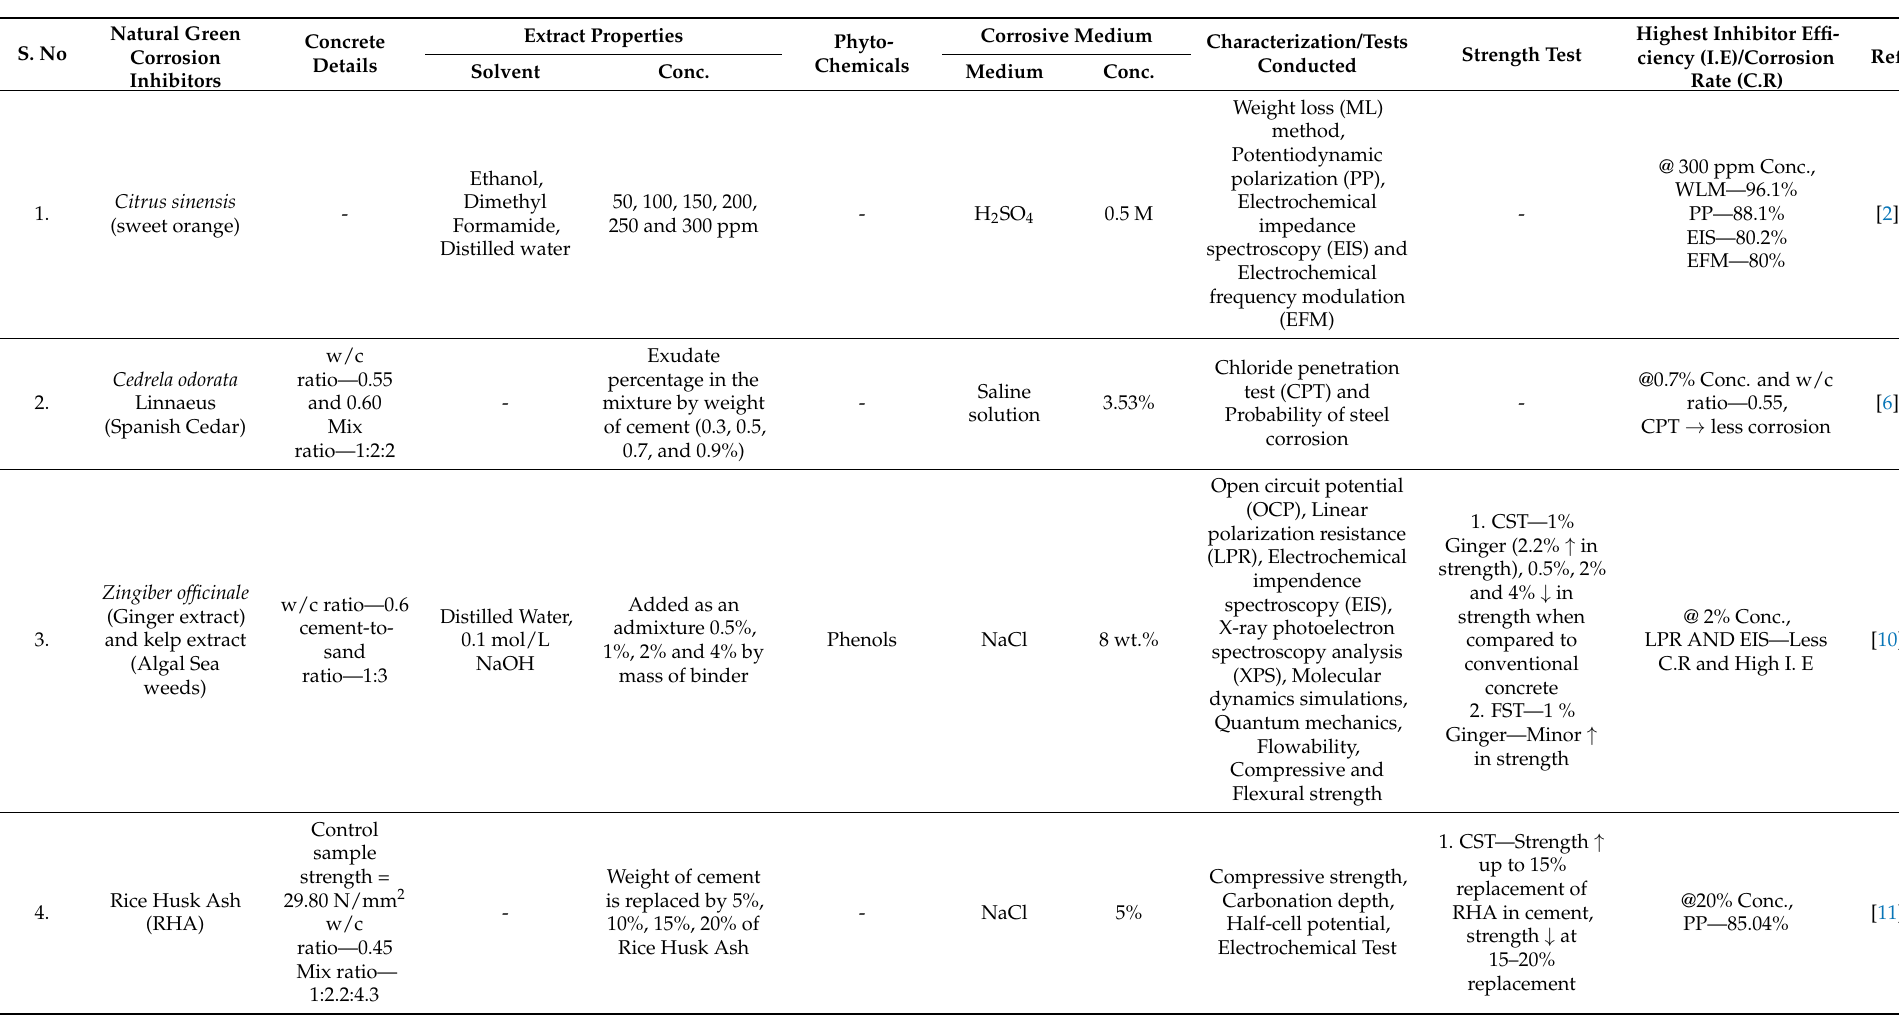
Table 2. Carbon Steel/Steel mentioned in